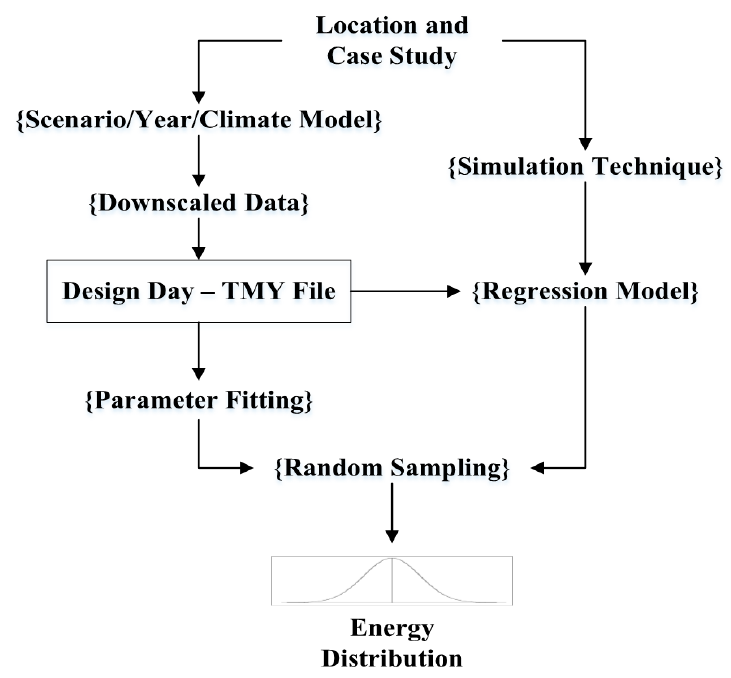
Figure 5. Sample probabilistic approach to propagate building energy uncertainties.